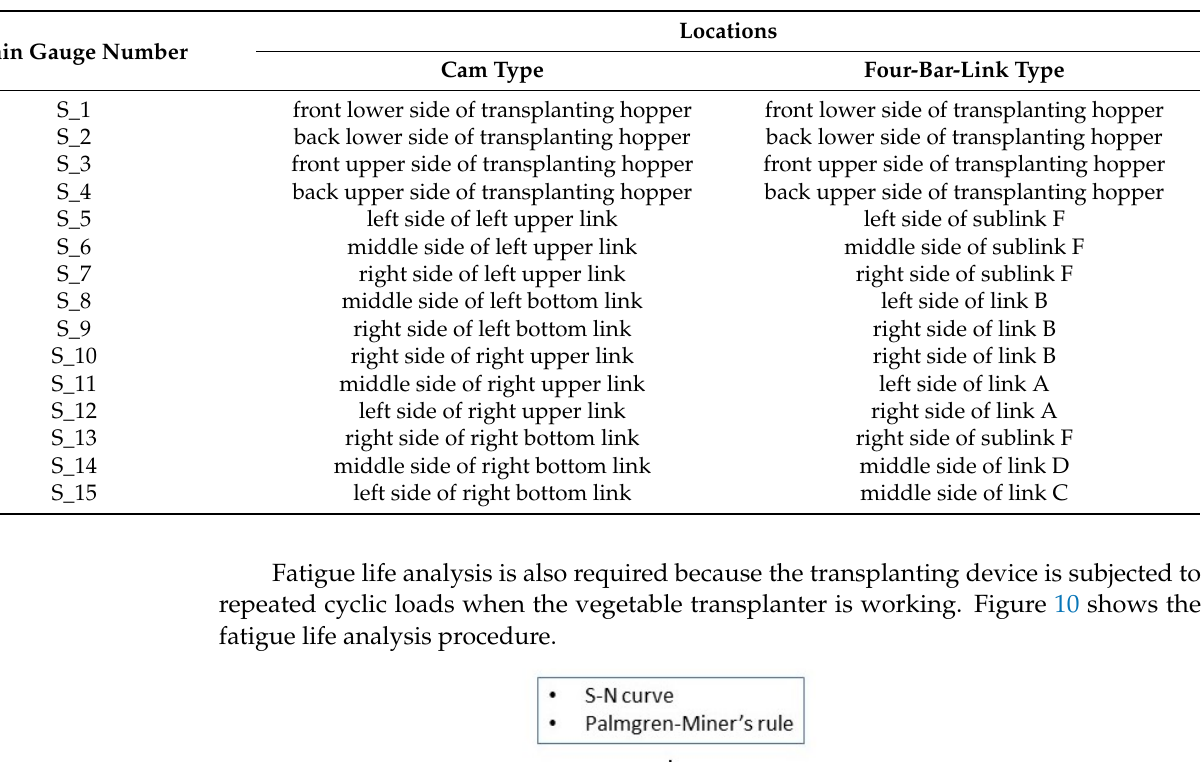
Table 3. Detailed description of strain measurement location.